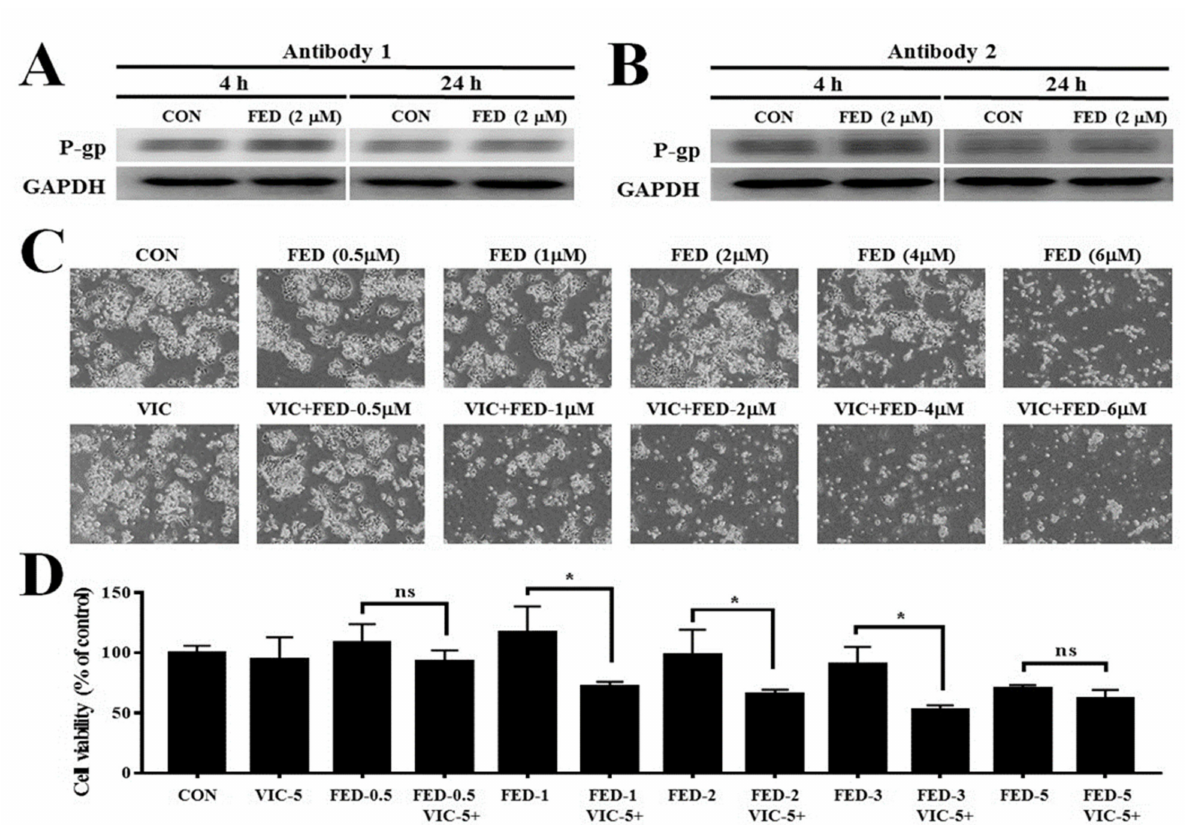
Figure 5. Fedratinib did not change P-gp protein levels. ( A , B ) KBV20C cells were plated on 60 mm diameter dishes and treated with 2 µ M fedratinib (FED-2) or 0.1% DMSO (CON). After 4 h or 24 h, Western blot analysis was performed using antibodies against ( A ) P-gp (Antibody 1 from Cell signaling company), ( B ) P-gp (Antibody 2 from Santia Cruz company), and GAPDH. ( C ) Drug- resistant KBV20C were grown on 60 mm diameter dishes and treated with 5 nM vincristine (VIC), 0.5 µ M fedratinib (FED-0.5), 1 µ M fedratinib (FED-1), 2 µ M fedratinib (FED-2), 4 µ M fedratinib (FED-4), 6 µ M fedratinib (FED-6), 5 nM VIC with 0.5 µ M fedratinib (VIC-5 + FED-0.5), 5 nM VIC with 1 µ M fedratinib (VIC-5 + FED-1), 5 nM VIC with 2 µ M fedratinib (VIC-5 + FED-2), 5 nM VIC with 4 µ M fedratinib (VIC-5 + FED-4), 5 nM VIC with 6 µ M fedratinib (VIC-5 + FED-6), or 0.1% DMSO (CON). After 2 days, all cells were observed using an inverted microscope at x40 magnification. ( D ) Drug-resistant KBV20C were plated on 96-well plates and grown to 30–40% confluence. The cells were then treated with 5 nM vincristine (VIC-5), 0.5 µ M fedratinib (FED-0.5), 1 µ M fedratinib (FED-1), 2 µ M fedratinib (FED-2), 3 µ M fedratinib (FED-3), 5 µ M fedratinib (FED-5), 5 nM VIC with 0.5 µ M fedratinib (VIC-5 + FED-0.5), 5 nM VIC with 1 µ M fedratinib (VIC-5 + FED-1), 5 nM VIC with 2 µ M fedratinib (VIC-5 + FED-2), 5 nM VIC with 3 µ M fedratinib (VIC-5 + FED-3), 5 nM VIC with 5 µ M fedratinib (VIC-5+FED-5), or 0.1% DMSO (CON). Cell viability assay was performed as described in experiments repeated in triplicate. For co-treatments, significantly different at * p < 0.05